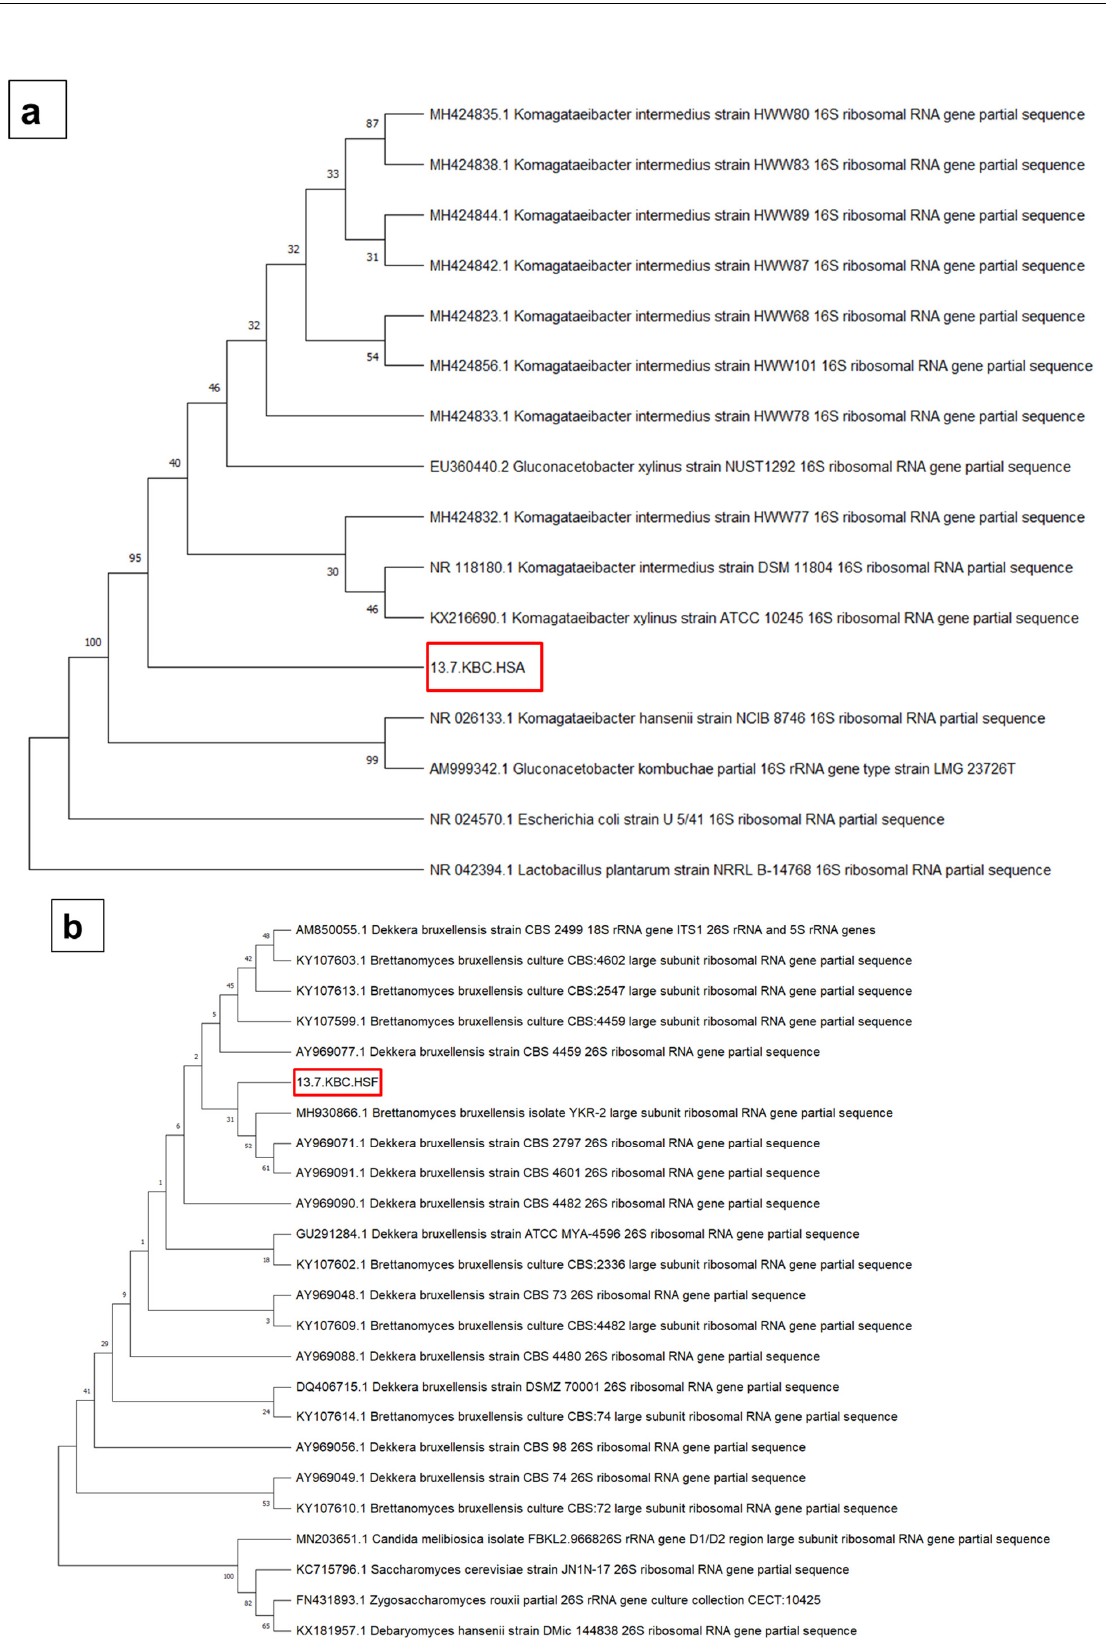
Figure 1. Neighbor-Joining tree of the sequencing result based after BLAST analysis. ( a ) Bacterial isolate’s 16S rRNA sequence; ( b ) yeast isolate’s 26S rRNA sequence with closely identical sequences and several distant species. The tree was reconstructed using 500 bootstrapping. Red box ( a ) 13.7.KBC.HSA indicates the bacterial isolate and ( b ) 13.7.KBC.HSF indicates yeast isolate from the Kombucha culture.